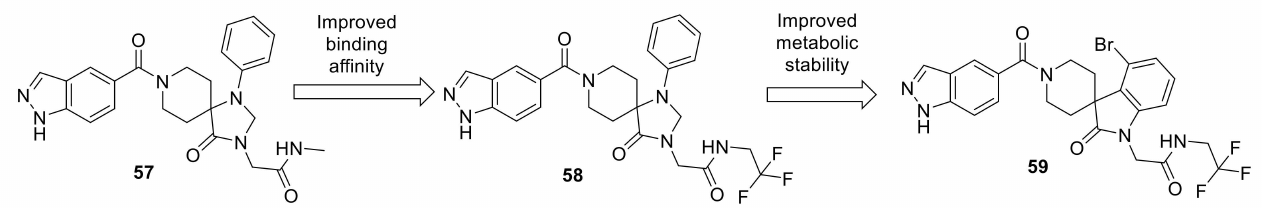
Figure 25. Chemical structure of compounds 57 – 59